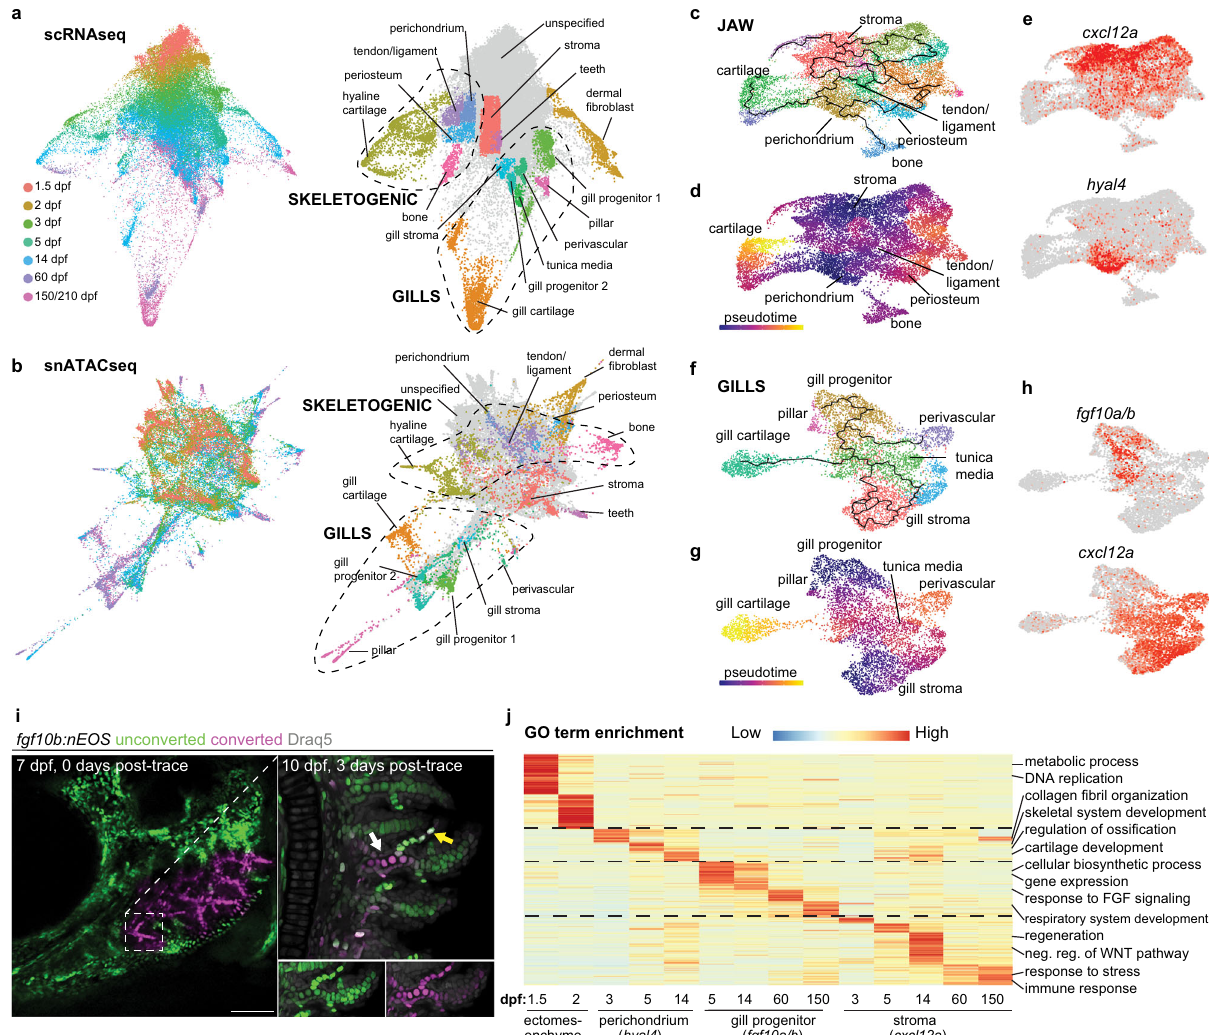
Fig. 2 Progressive emergence of region-speci fi c lineage programs. a , b STITCH plots connect individual scRNAseq and snATACseq datasets across the zebra fi sh lifetime. Cell type annotations show divergence of CNCC ectomesenchyme into skeletogenic, gill, dermal fi broblast, and stromal branches. c – e Pseudotime analysis using Monocle3 of the jaw skeletogenic subset (combined 5 and 14 dpf) shows a cxcl12a + stromal branch, and a hyal4 + branch connected to cartilage, bone, periosteum, and tendon and ligament. f – h Pseudotime analysis of gill subsets (combined 5 and 14 dpf) shows a cxcl12a + stromal branch, and a fgf10a/b + branch connected to gill pillar, tunica media, and perivascular cells, as well as a distinct type of gill cartilage. i Following UV-mediated photoconversion of fgf10b:nEOS from green to magenta in a subset of fi laments, re-imaging 3 days later revealed contribution of converted cells to gill chondrocytes (white arrow) and pillar cells (yellow arrow, white signal re fl ects mixture of previously converted magenta and continued expression of new unconverted green fgf10b:nEOS ) ( n = 3). Draq5 labels nuclei in gray. At 10 dpf, below insets show the region designated by the arrows for individual green and magenta channels with Draq5. j Gene ontology (GO) terms of biological processes for the respective clusters at the stages indicated. Heatmap re fl ects the negative log of the adjusted p value of one-sided Fisher ’ s exact test. Ectomesenchyme is de fi ned as the average of all cells at 1.5 and 2 dpf stages. Scale bar, 100 μ